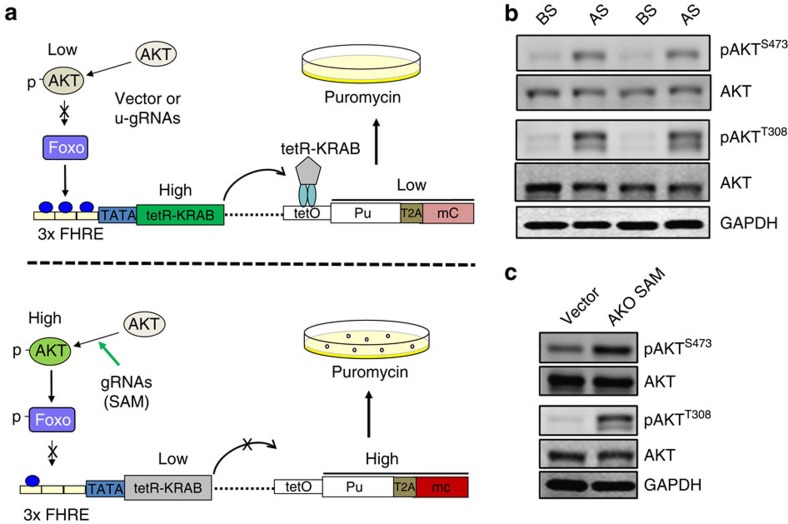
Identification of lncRNAs capable of activating AKT by SAM library screen along with an AKT reporter.(a) Schematic description of principle for the AKT reporter used to screen the SAM library. SAM gRNAs that can activate AKT activity are enriched by puromycin selection. (b) Detection of AKT activity for cells before selection (BS) and cells after selection (AS) by western blot. (c) AK023948 SAM gRNA increases the pAKT level. A mixed pool of five SAM gRNAs against AK023948 were introduced into MCF-7 cells carrying dCas9-VP64 and pMS2-p65-HSF1 by infection and cellular extract was prepared for western blot 2 days after infection.